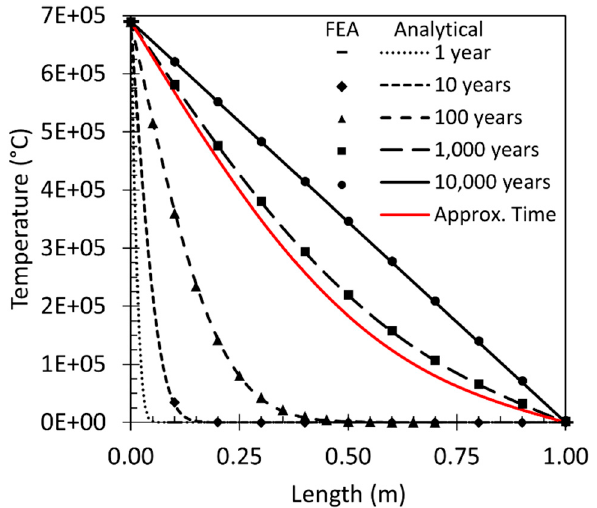
Figure 5. Pressure distribution along the sample with time intervals ranging from 1 year to 10,000 years. The analytical solution is represented by solid and dashed lines while the FEA model results are depicted by data points. Note that the FEA results are in agreement with the analytical solution.